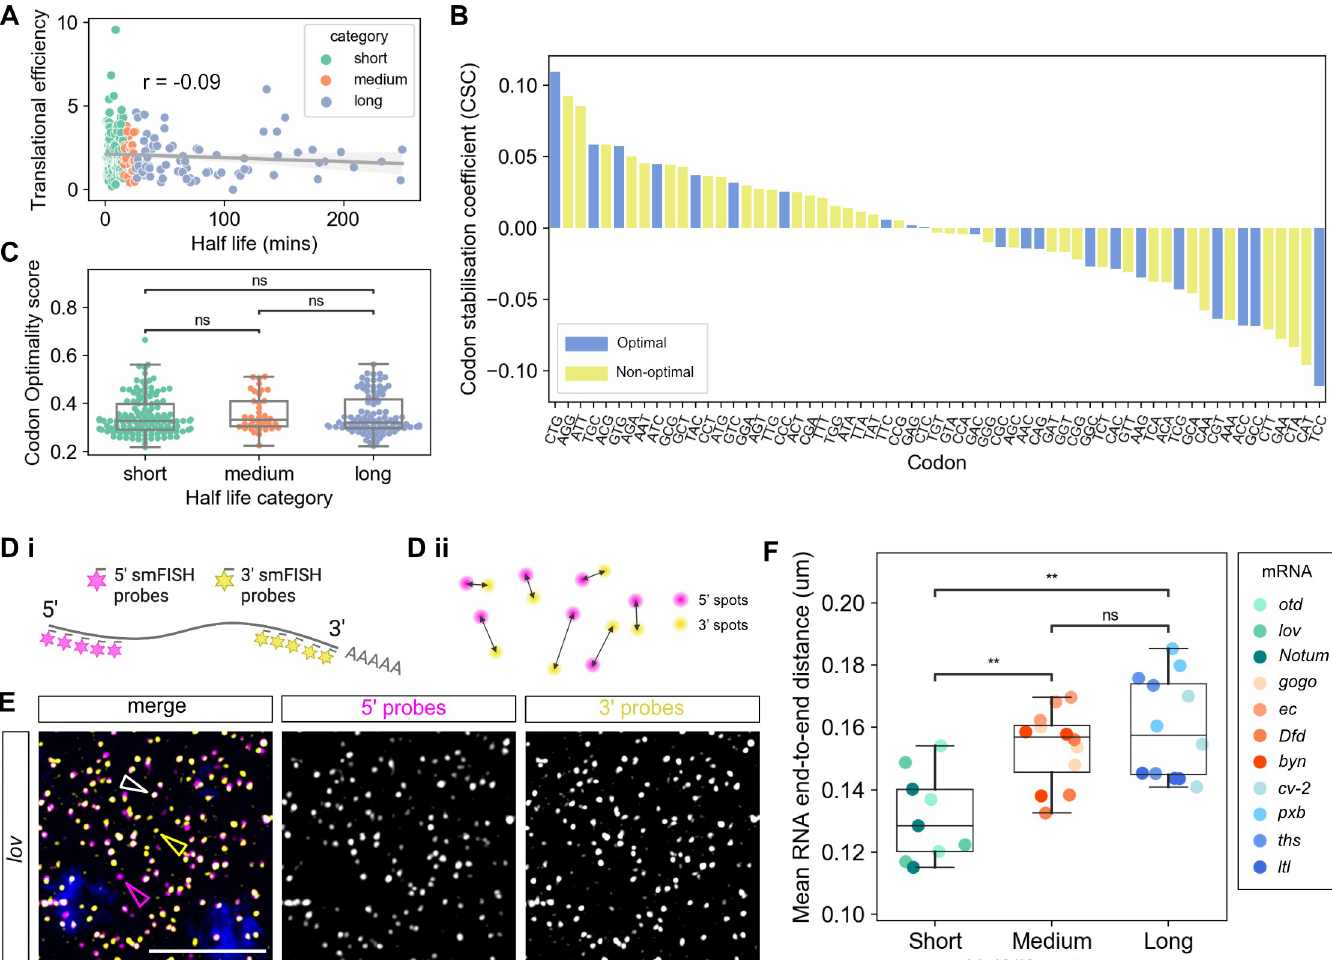
Fig 4. mRNA properties and stability. (A) Half-life (x-axis) versus the translation efficiency from 2–3 hour embryos [42]. In this and subsequent panels points representing transcripts are coloured by half-life category (Pearson’s r = − 0.09, p = 0.18). (B) CSCs calculated from our estimated half-lives showed no difference in the proportion of optimal (blue) and non-optimal codons (yellow) (chi-squared test p = 0.79). (C) Proportion of optimal codons within transcripts from each half-life category. No significant difference was observed in the proportion of optimal codons within each category, tested by independent t test (short vs. med p = 0.5; short vs. long p = 0.7; med vs. long p = 0.7). (Di) Schematic showing detection of the 5 0 (magenta) and 3 0 (yellow) ends of each mRNA with different smFISH probe sets. (Dii) Spots belonging to the same mRNA are matched (see Materials and methods). (E) Maximum projection of 6 slices from a confocal image showing smFISH detection of the 5 0 and 3 0 ends of lov mRNAs with lone 5 0 ends, 3 0 ends, and colocalised ends labelled by magenta, yellow, and white arrowheads, respectively. Scale bars: 5 μ m. In the uncropped image from this embryo there are 5,668, 1,645, and 3,620 intact, lone 5 0 and lone 3 0 signals, respectively. For absolute numbers of intact mRNAs and lone ends for all mRNAs, see S9A Fig. (F) Graph shows the end-to-end distances of mRNAs with different stabilities, n = 3 embryos per mRNA. Data are mean distances across all colocalised mRNAs in each embryo ( n > 220 whole RNAs for all images). mRNAs are grouped by their half-life category and the hue in each category corresponds to the order of the half-lives (lighter colour refers to shorter half-life). Short half-life mRNAs are more compact than both medium ( p = 3.1 × 10 − 3 ) and long ( p = 1.6 × 10 − 3 ) half-life mRNAs. No significant difference in the end-to-end distance was seen between medium and long half-life transcripts ( p = 8.9 × 10 − 1 ). Underlying data can be found in S1 Data. CSC, codon stabilisation coefficient; smFISH, single-molecule fluorescent in situ